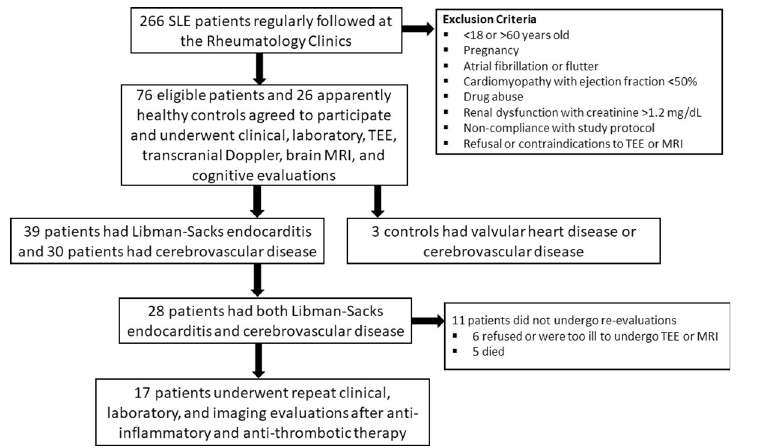
Fig 1. Study population recruitment, selection, evaluations, and